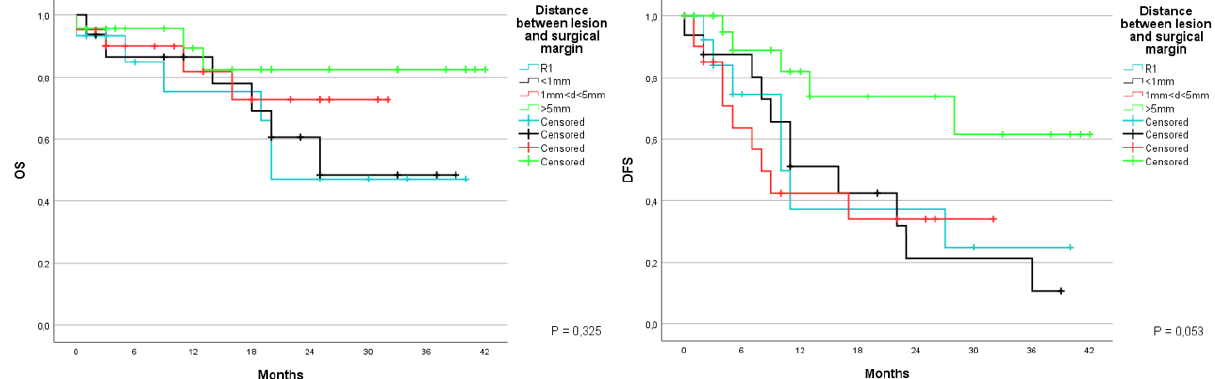
Figure 12. Kaplan-Meier Curve for OS and DFS in patients who underwent liver resection for CRLM stratified according to distance between lesion and surgical margin. OS: Overall Survival; DFS: Disease Free Survival; CRLM: Colorectal liver